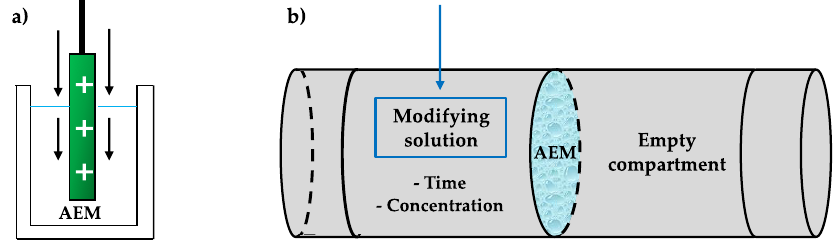
Figure 4. Scheme of dip coating technique highlighting the importance of controlling immersion/contact time and modifier concentration in ( a ) total immersion and ( b ) one-side modification.